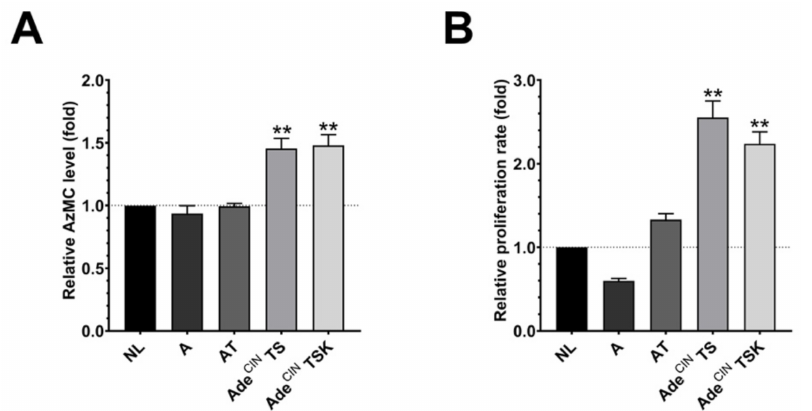
Figure 2. Increased H 2 S production and increased cell proliferation in Ade CIN TS and Ade CIN TSK organoids. ( A ) AzMC-aided live cell imaging quantification of NL, A, AT, Ade CIN TS and Ade CIN TSK organoids after 7 days in culture. ( B ) Cell proliferation rate of NL, A, AT, Ade CIN TS and Ade CIN TSK organoids after 7 days in culture. Data represent mean ± SEM of at least 4 independent experiments. ** p < 0.01 compared to